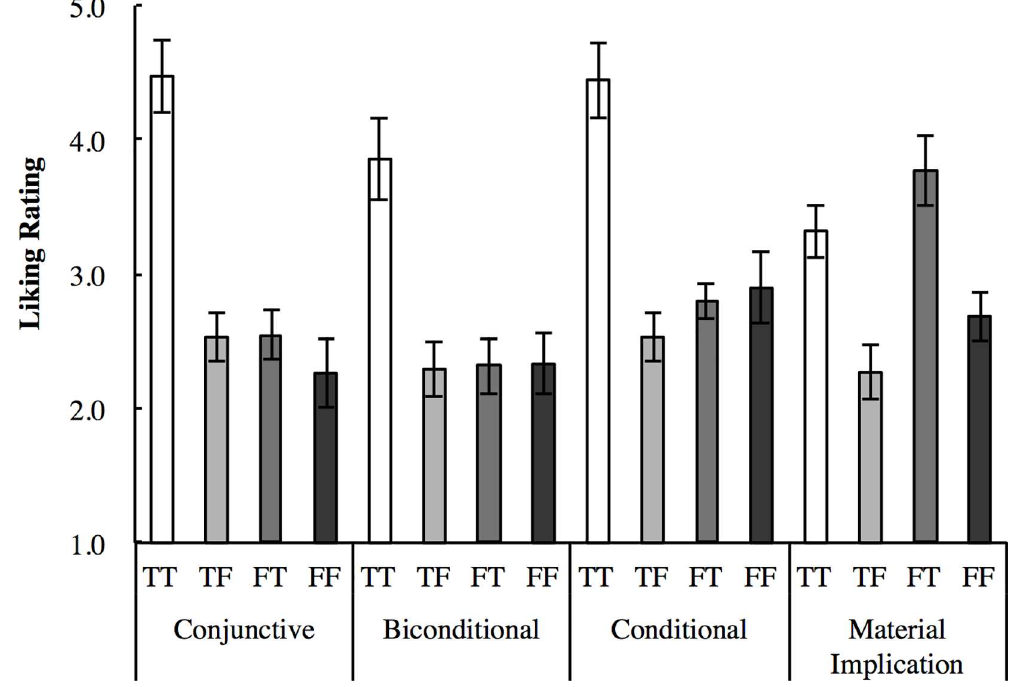
Fig 2. Mean Liking Ratings and Cousineau-Morey Difference Adjusted 95% Confidence Intervals for the Four Logical Forms and Targets in Experiment 1.